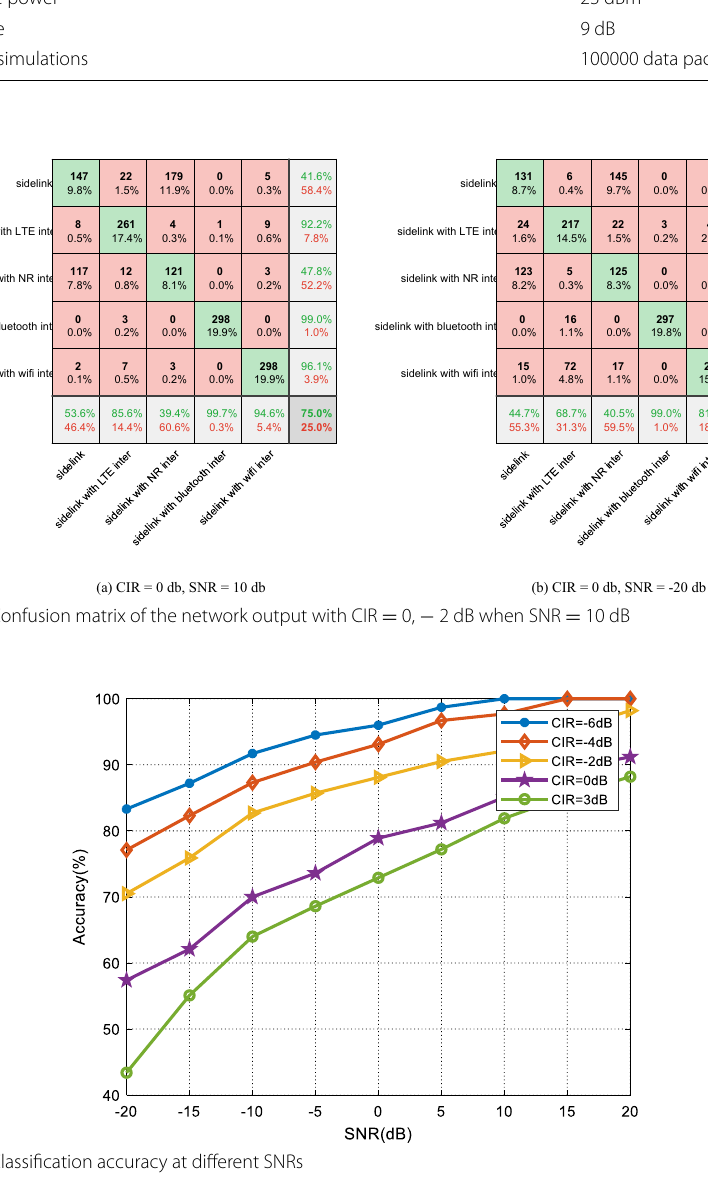
Fig. 12 Classification accuracy at different